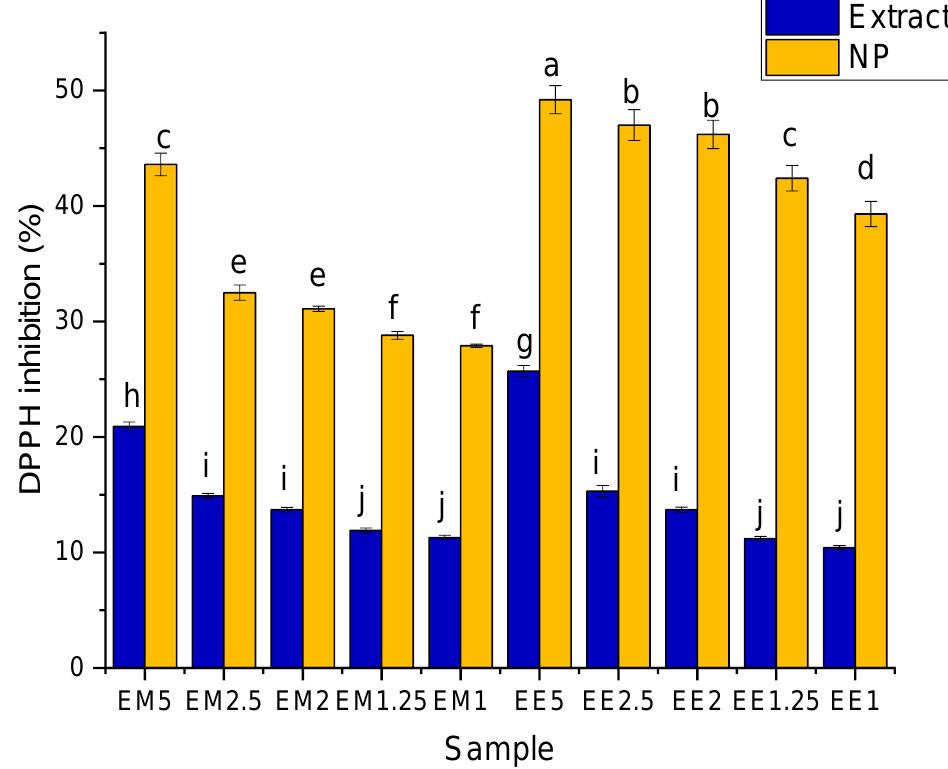
Figure 7. Antioxidant activity (expressed as DPPH inhibition — %) for the phytosynthesized nano- particles and corresponding extracts. Values represent the mean ± SE, n = 5 per treatment group; values without a common lowercase letter differ statistically ( p < 0.05) as analyzed via one-way ANOVA and the TUKEY test.